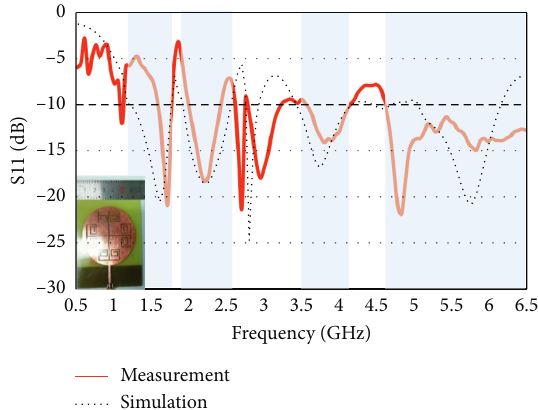
Figure 13: Measurement and simulation of S11 of the